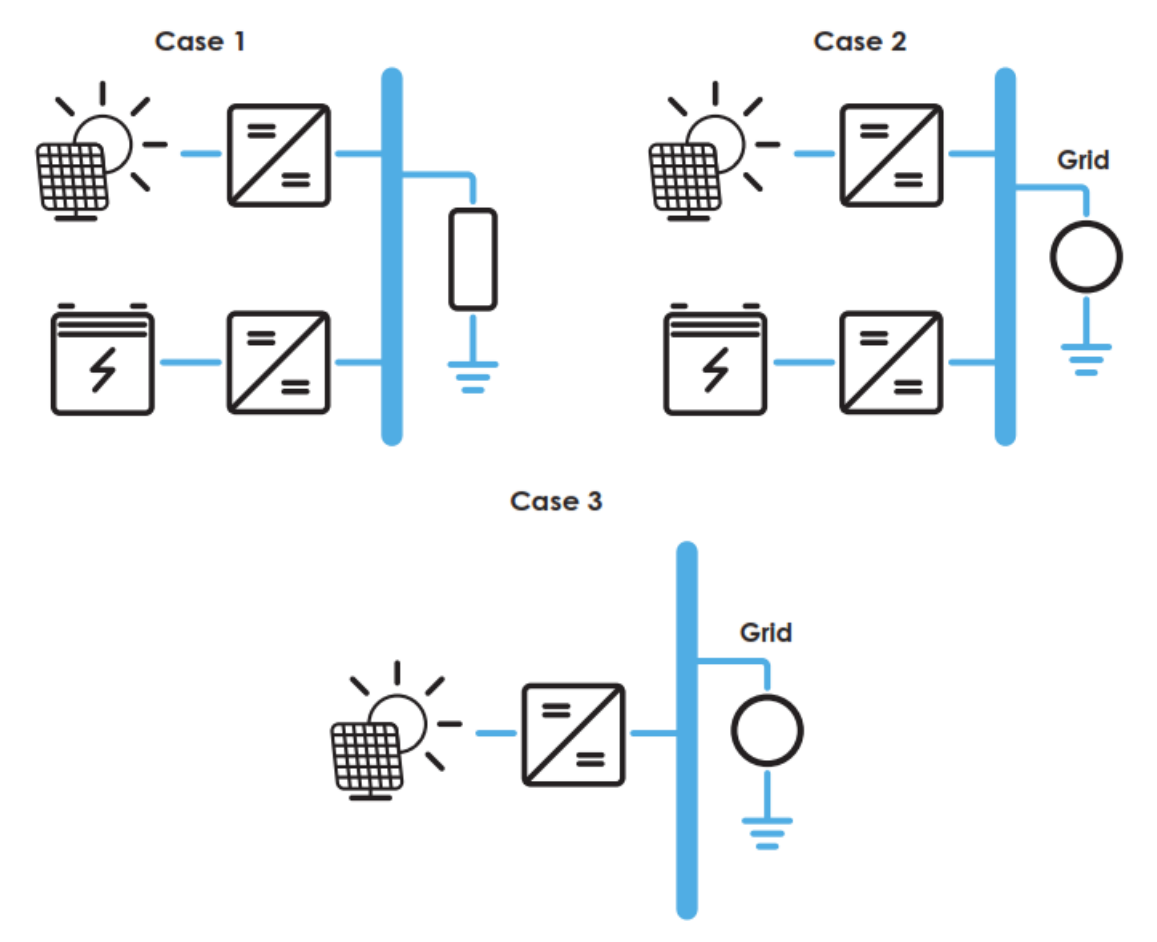
Figure 1. Scenarios. Case 1: PV-Battery standalone system; Case 2: PV-Battery system connected to the grid; Case 3: PV system connected to the grid.